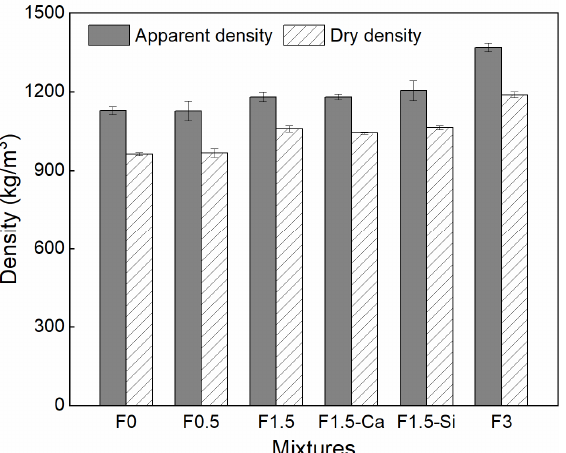
Figure 12. Apparent and dry densities of LWAC with coir fibers of various contents and different treatments.